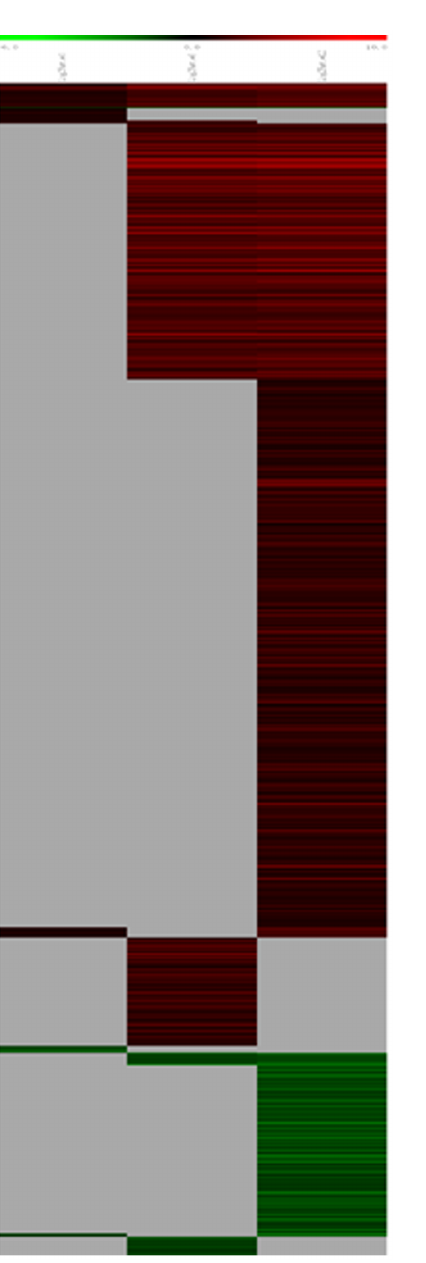
Figure 2. The Heat Map of gene expression profiles in the kidney of Tg26 mice at three time points: 4, 8, and 12 weeks of age when mice developed mild, moderate and severe kidney injury. The data were normalized by comparing to control littermate mice as described in the method.